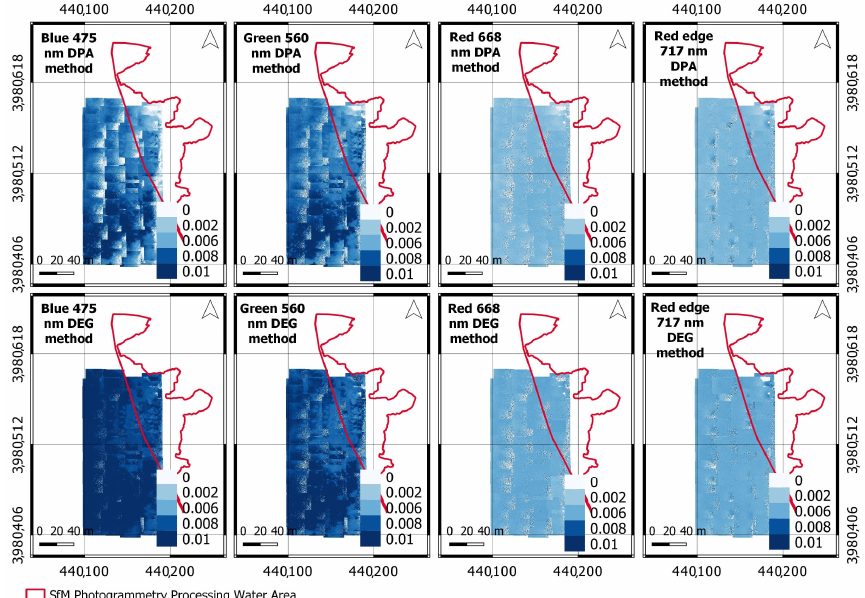
Figure 5. All-bands orthomosaics at ˙Cumnija study location by using both the DPA and DEG methods for Rrs retrieval. Rrs values are given in sr − 1 . The water area covered after SfM photogrammetric processing is marked in red.